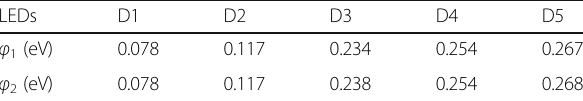
Table 2 Conduction band barrier heights of each NPN-AlGaN junction for LEDs D i ( i = 1, 2, 3, 4, and 5)